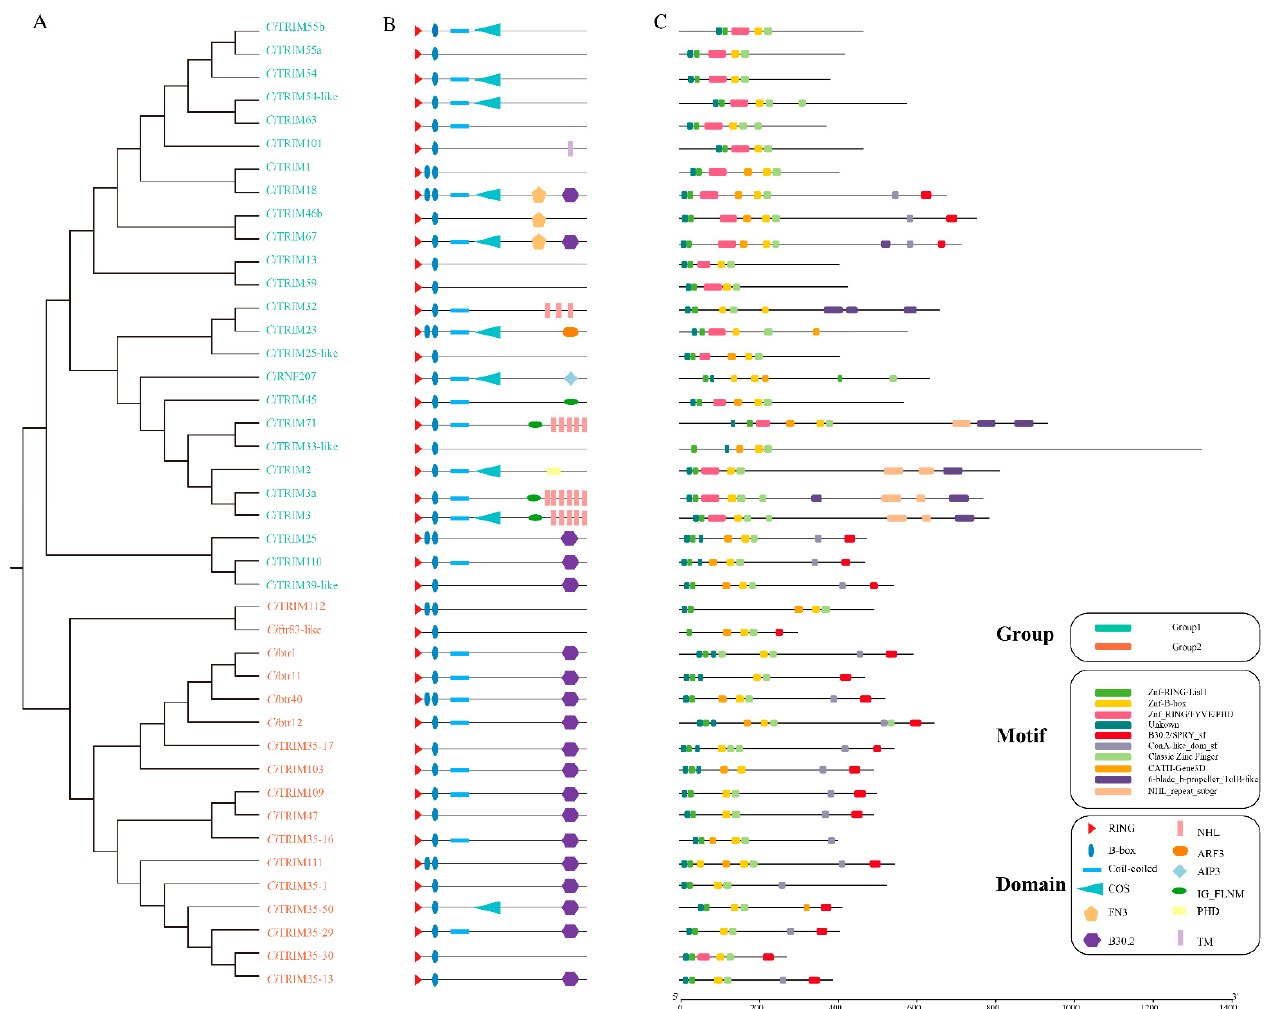
Figure 1. Dendrogram, domains and motifs of Ci TRIMs. ( A ) The dendrogram of Ci TRIMs was divided into two large branches, indicated in green and red. ( B ) The schematic diagram of domain architectures of Ci TRIMs. ( C ) Conserved motifs of Ci TRIMs predicted by MEME. The scale on the bottom margin was measured by amino acid number.